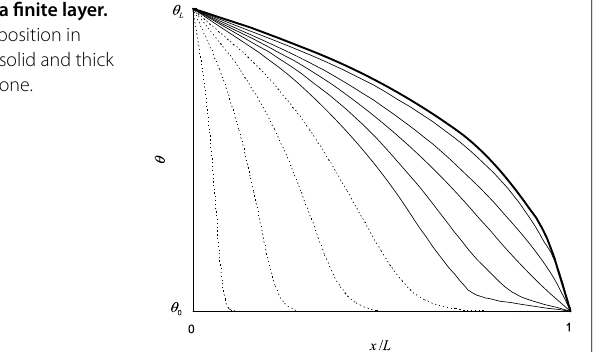
Figure 1 Horizontal infiltration in a finite layer. Dotted lines show the wetting front position in semiinfinite boundary problem, and solid and thick solid lines show it in finite boundary